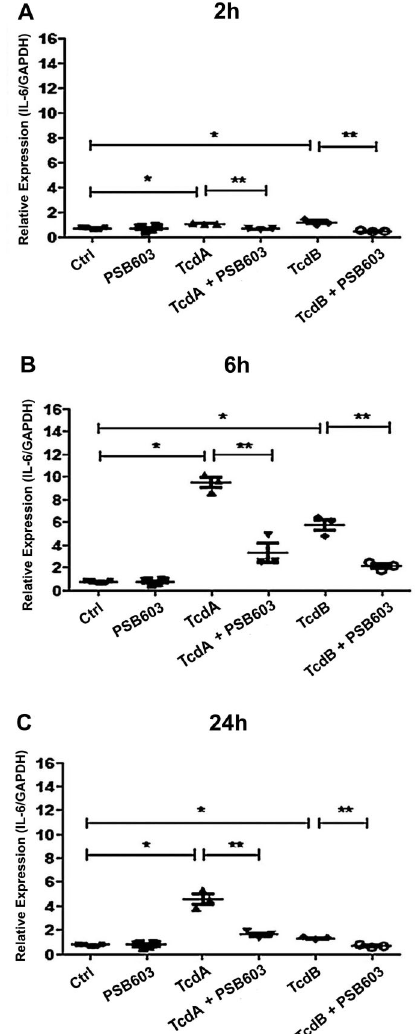
Figure 3 . Effect of A 2B AR antagonist (PSB603) on C. dif fi cile - induced interleukin (IL)-6 gene expression in vitro. HCT-8 cells were incubated with TcdA and TcdB at 10 ng/mL with or without PSB603. Analyses of IL-6 mRNA expression at 2 ( A ), 6 ( B ), and 24 ( C ) h were performed by qPCR. Each treatment was done in triplicate per time-point. *P o 0.05, **P o 0.05 (one- way ANOVA with Bonferroni post-test). Vertical lines indicate mean ±